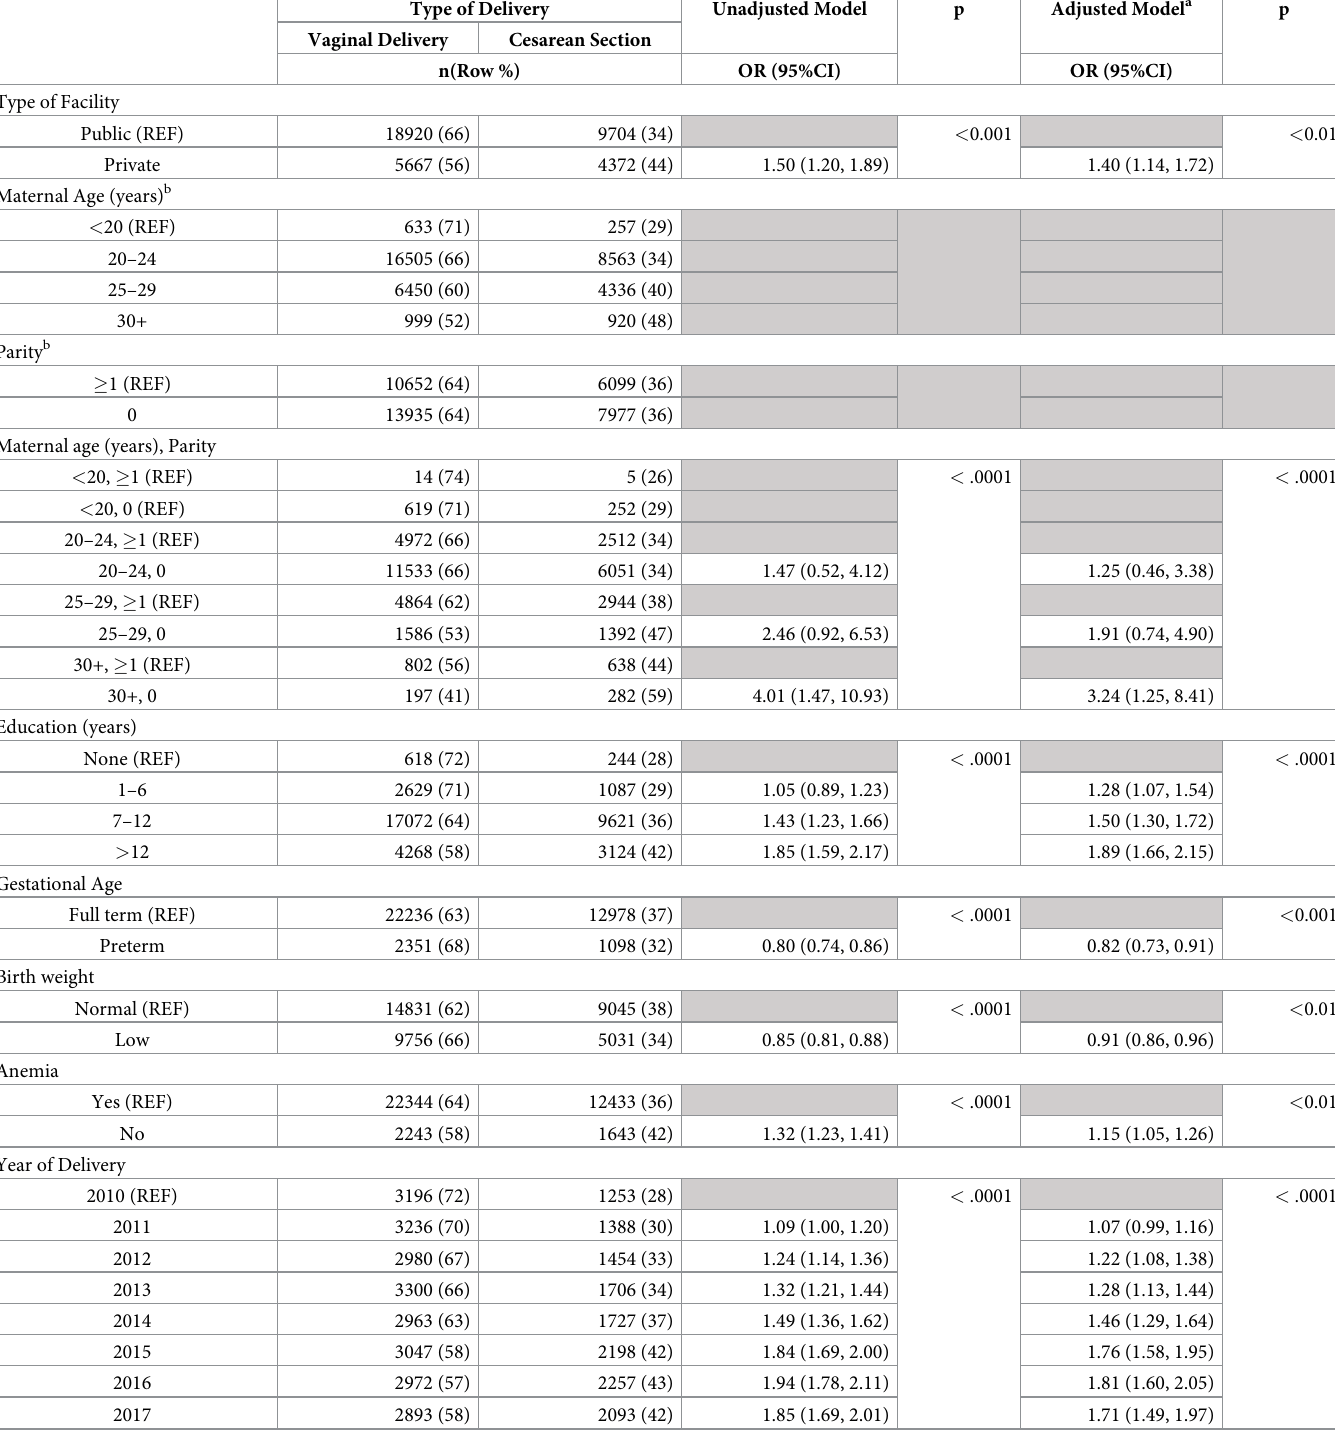
Table 2. Odds ratios (OR) and 95% Confidence Intervals (CI) obtained from multivariable generalized estimating equations models evaluating the association of CS with type of facility adjusting for known risk